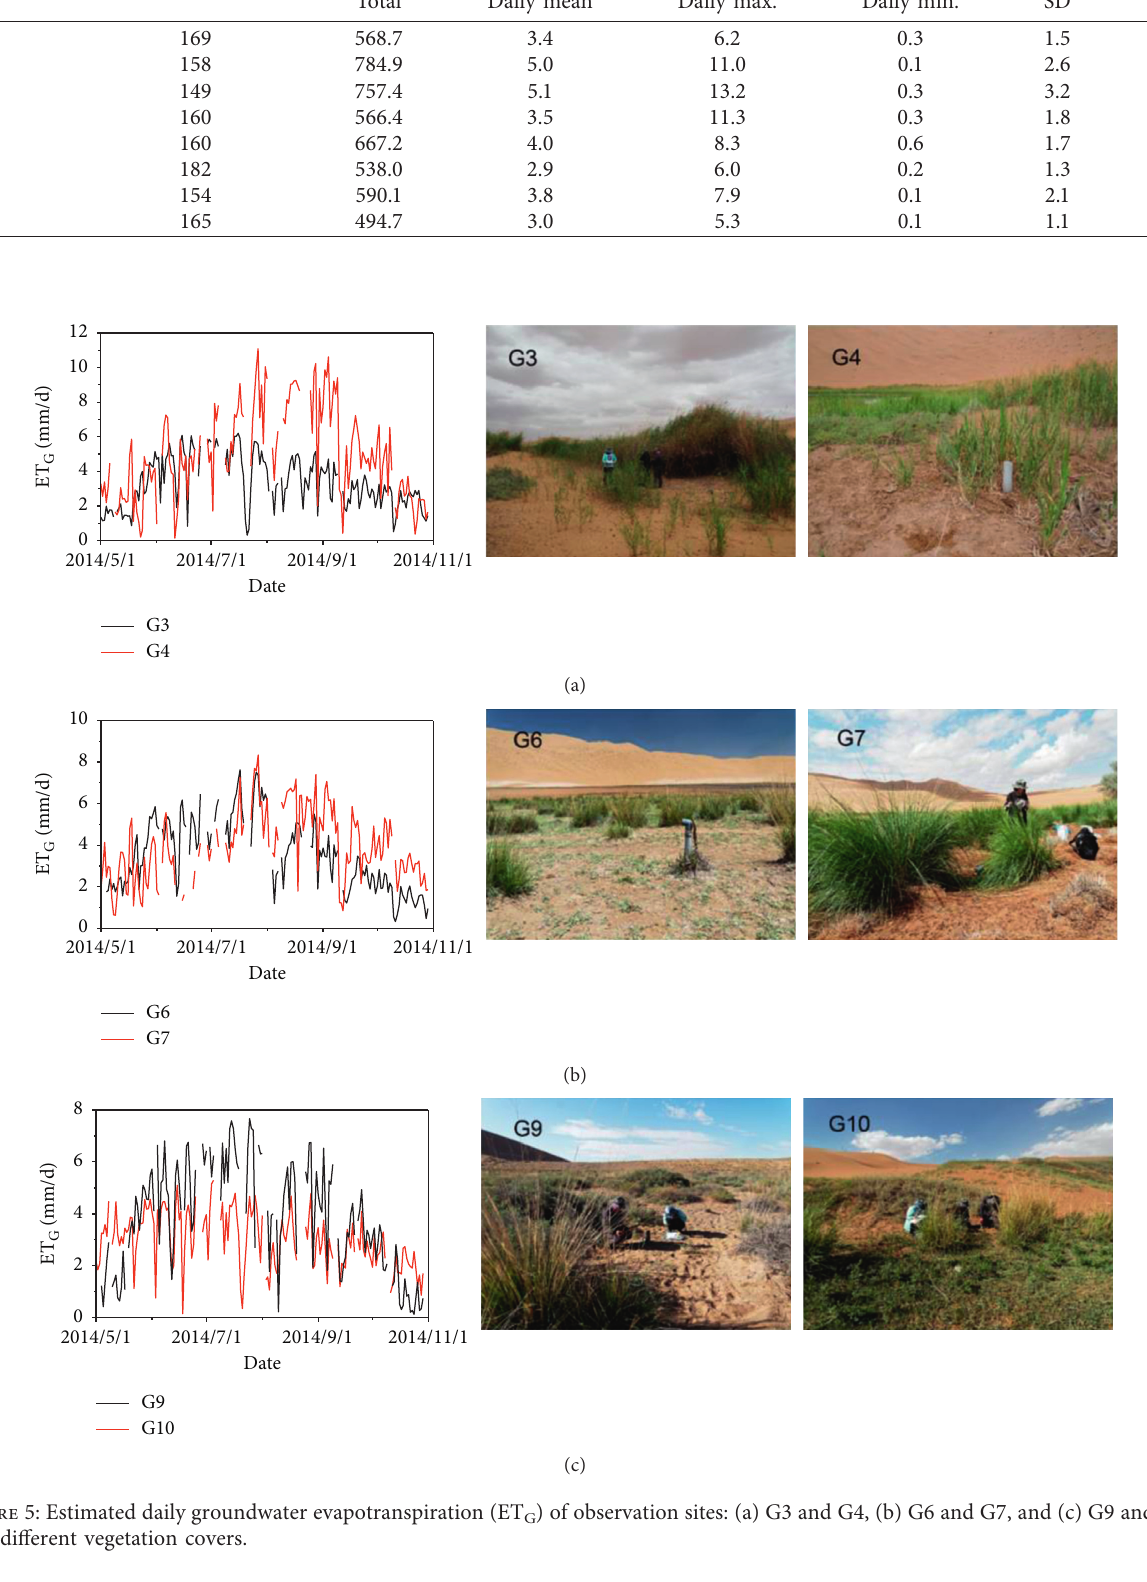
G ) of observation sites: (a) G3 and G4, (b) G6 and G7, and (c) G9 and G10